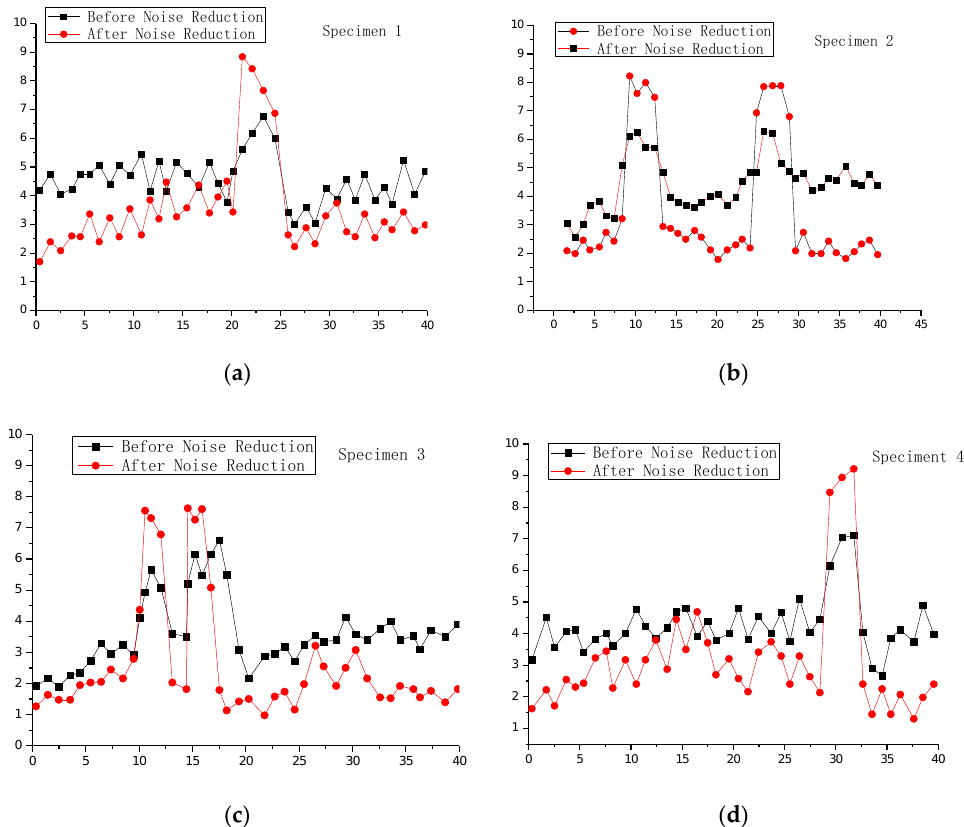
Figure 8. Comparison of signal sensitivity to four kinds of damage before and after noise reduction: ( a ) one shock damage, ( b ) two circular hole-like damages, ( c ) two 1D linear damages, ( d ) two small defects inside.